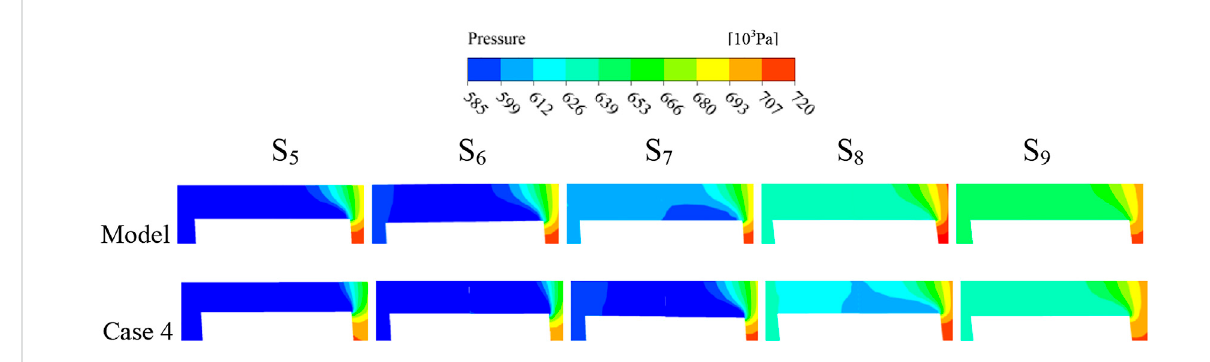
FIGURE 11 Pressure distribution of S 5 ~ S 9 on the E region before and after complex pattern.